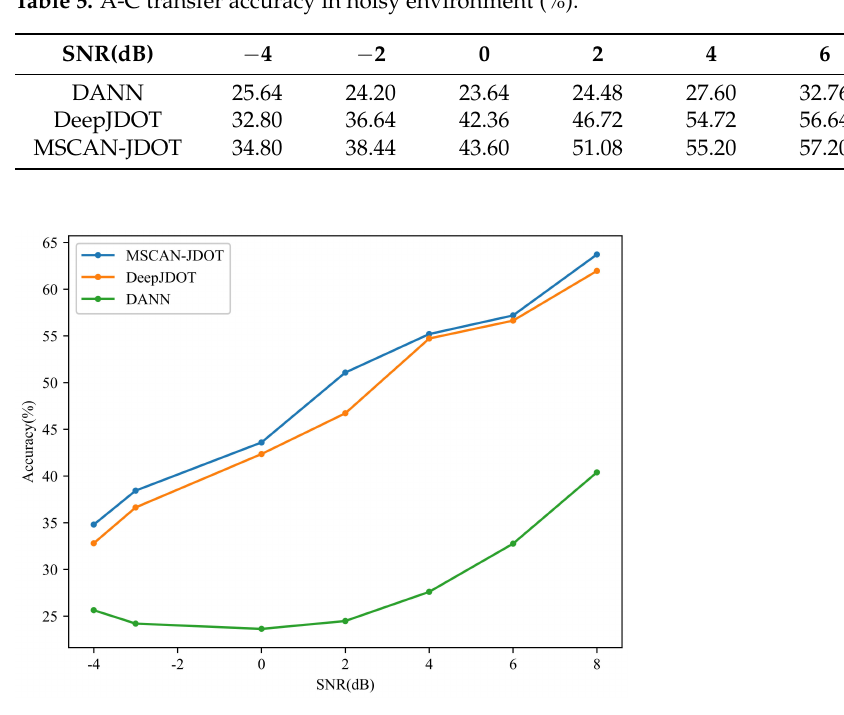
Figure 11. Comparison of A-C transfer results in noisy